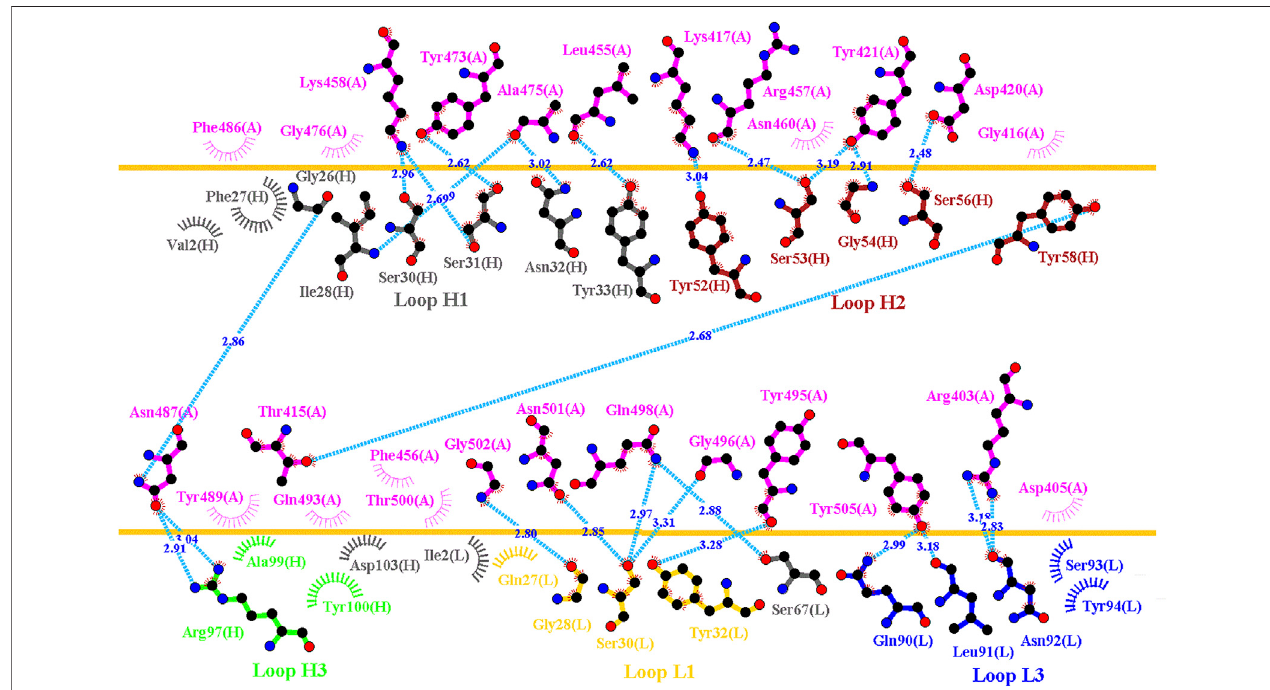
FIGURE3| InteractionalnetworkoftheRBDandB38antibodyanalyzedusingLIGPLOT.LIGPLOTwasemployedtoexaminetheinteractionnetworkoftheSARS- CoV-2 RBD and B38. The RBD and light and heavy chains of B38 are labeled A, H, and L, respectively. The golden yellow line denotes the interface of the RBD – B38 complex.TheinteractiveresiduesoftheRBDarelabeledandcoloredmagenta.Thehydrogenbondsandhydrophobicinteractionsarerepresentedbycyandashesand arcs with spokes radiating toward the ligand atoms with which they are in contact,